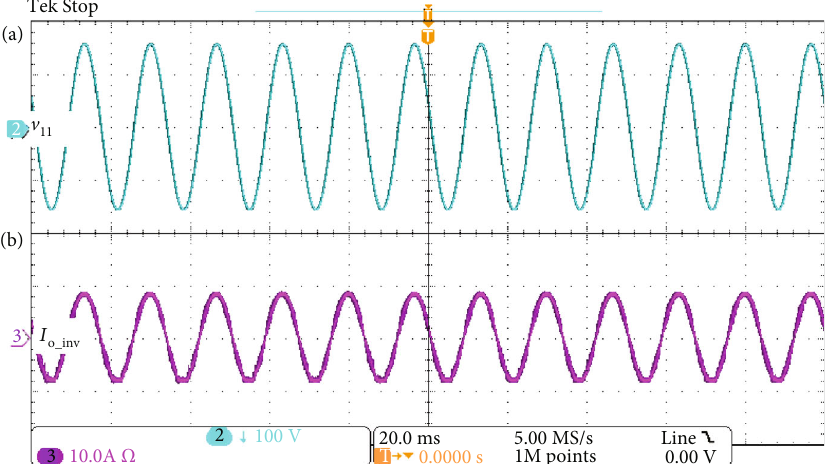
Figure 7: System operating at MPPT mode: (a) local voltage in residence 11 ( V 20ms/div.